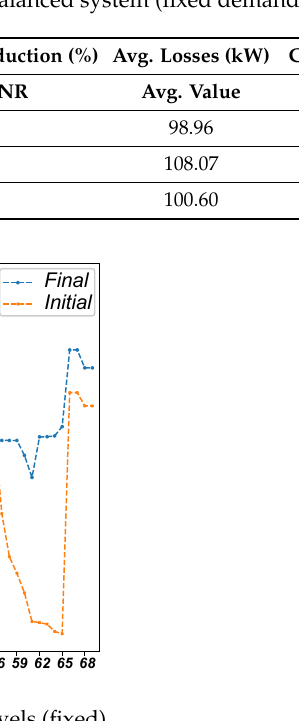
Table 6. Results found for the 69-bus 73-branch balanced system (fixed demand).